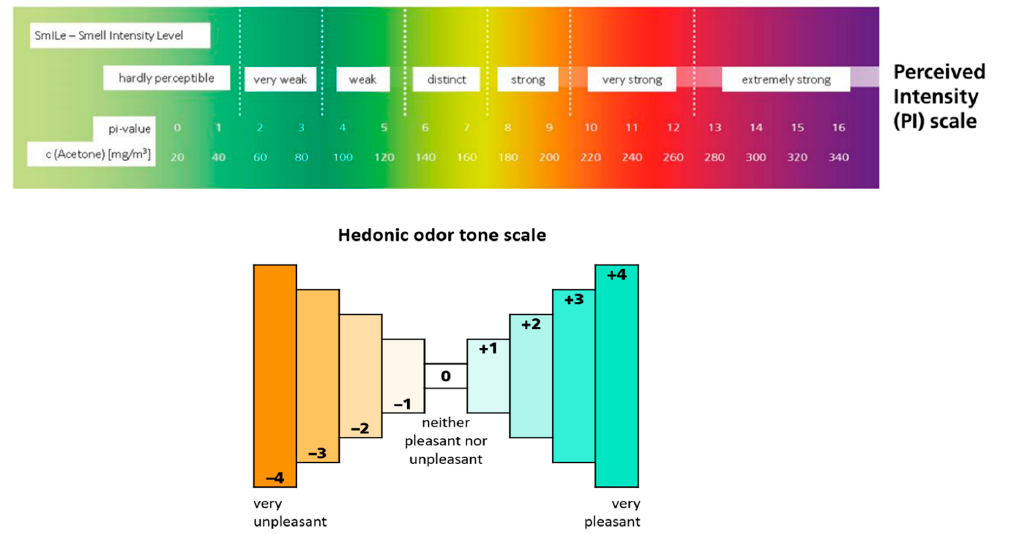
Figure 5. Top : Perceived intensity scale, Bottom : Hedonic odor tone scale.